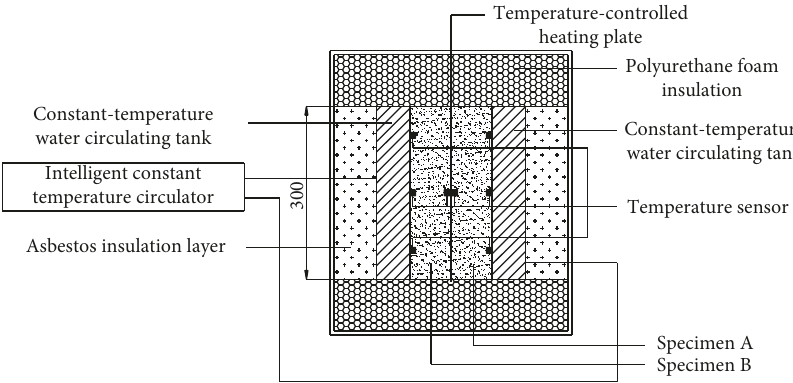
Figure 1: Schematic diagram of the test